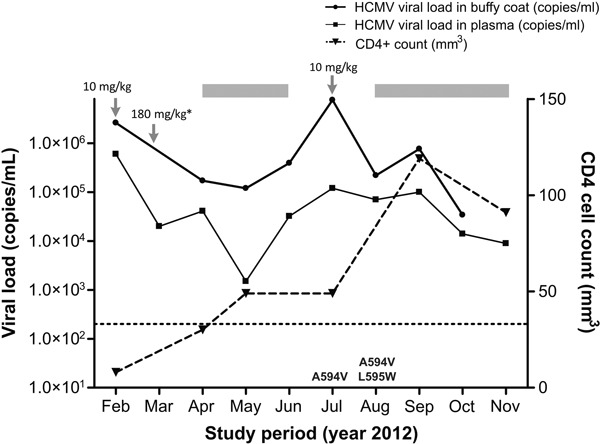
Changes in the human cytomegalovirus load (HCMV) (plasma and buffy coat) and
the CD4+ T cell count over the study period. Gray bars: continuous
treatment with 5 mg/kg daily ganciclovir iv. Changes in the
applied dose of ganciclovir are indicated at February and July. The ganciclovir
resistance mutations are indicated at the bottom of the graph.
*iv foscarnet.